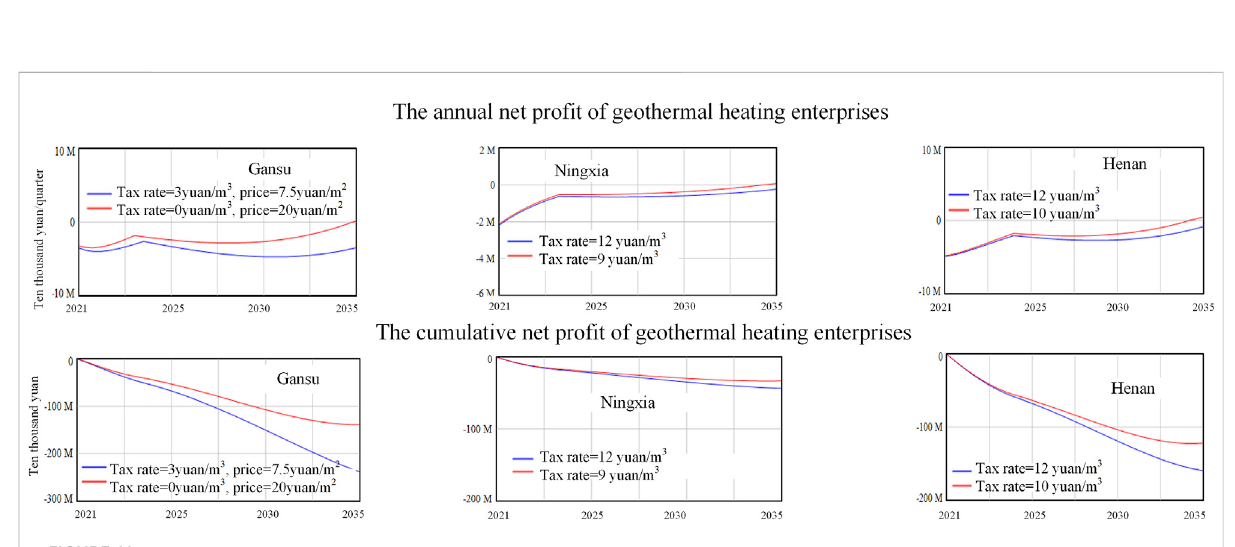
FIGURE 11 Forecast of annual net pro fi t and accumulated net pro fi t in Gansu Province, Ningxia Hui Autonomous Region and Henan